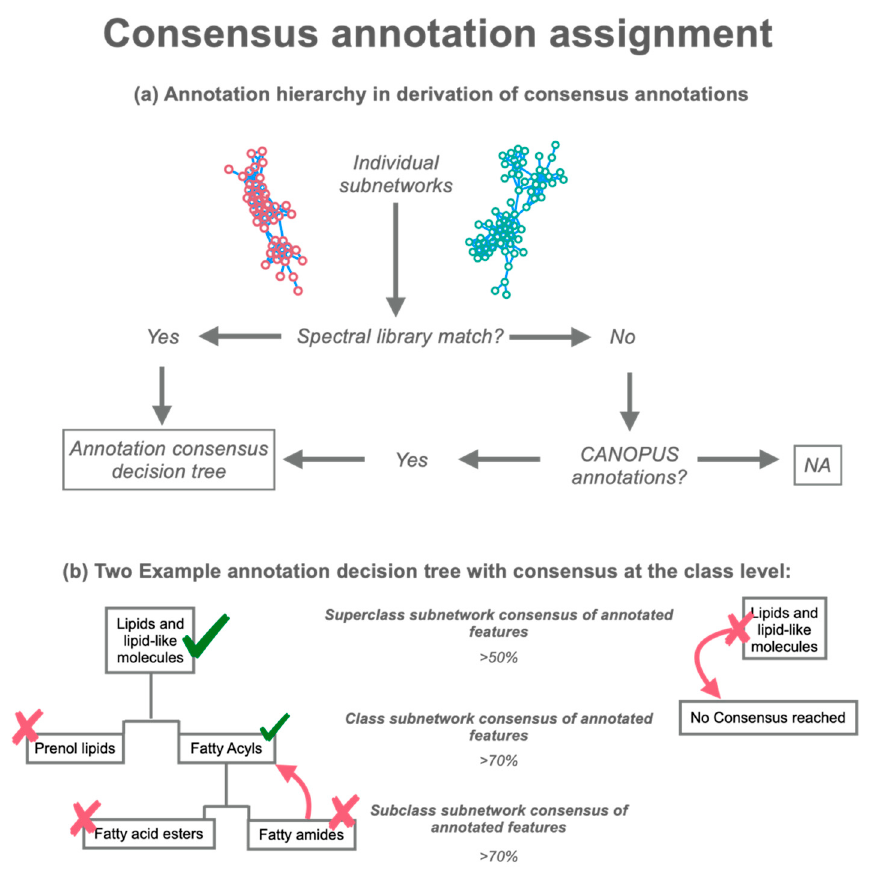
Figure 1. ConCISE consensus annotation pipeline. ( a ) Assignment hierarchy; identification of annotation sources within each molecular subnetwork. Spectral library matches are utilized prior to annotations from in silico annotation tools. ( b ) Consensus derivation decision tree used for either library spectral matches or in silico matches. Nodes with annotations must have consensus (>50%, >70%, >70%) at each classification level, respectively, (superclass, class and subclass) to receive the higher classification. If the nodes within the subnetworks cannot find a consensus above 50% at the superclass level, then ConCISE returns “No Consensus Reached” for that